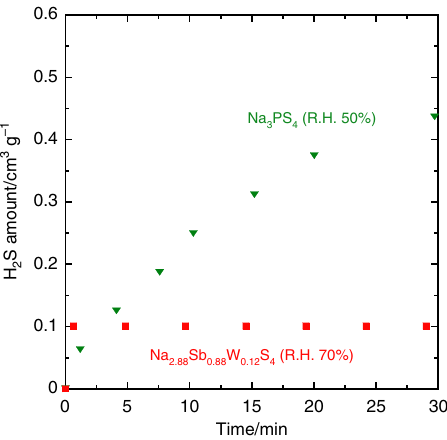
Fig. 4 Monitoring H 2 S gas generated from Na 2.88 Sb 0.88 W 0.12 S 4 as a function of exposure time to humid air (relative humidity (R.H.) = 70%). The H 2 S content is normalized by the weight of sulfur in the samples. For comparison, the same measurement was carried out for Na 3 PS 4 under a less-humid condition of R.H. =